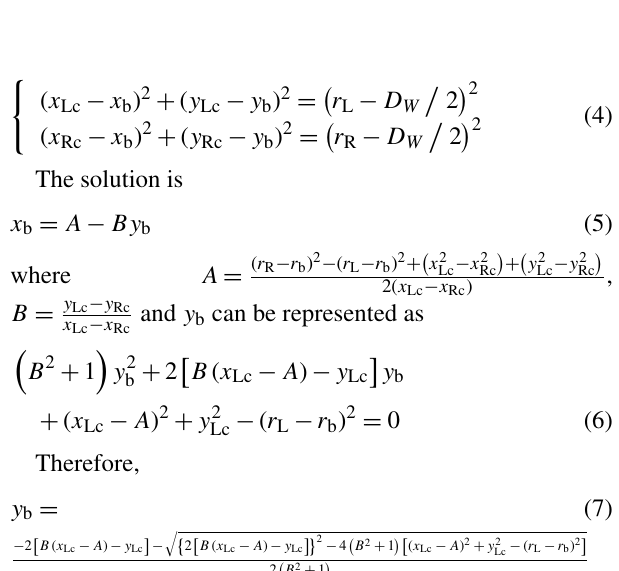
Figure 8. The left and right